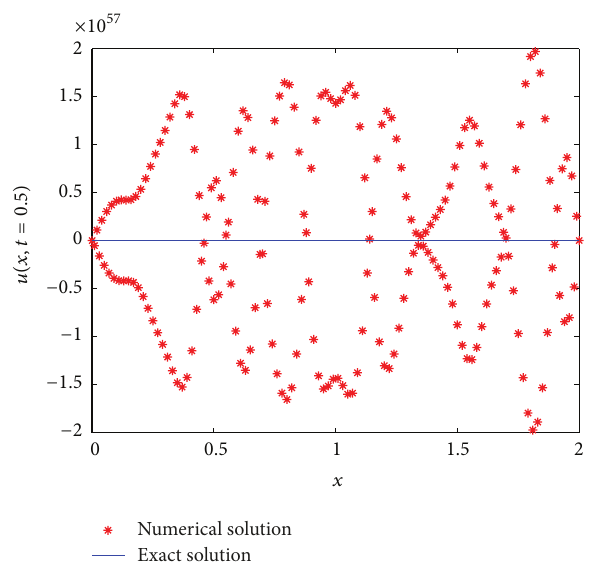
Figure 8: Comparison of the analytical solution and numerical solution for 𝛼 = 1.6 by Numerical Algorithm II (see (61)) with ℎ = 0.01, 𝜏 = 0.01 , which do not satisfy the stability (83).